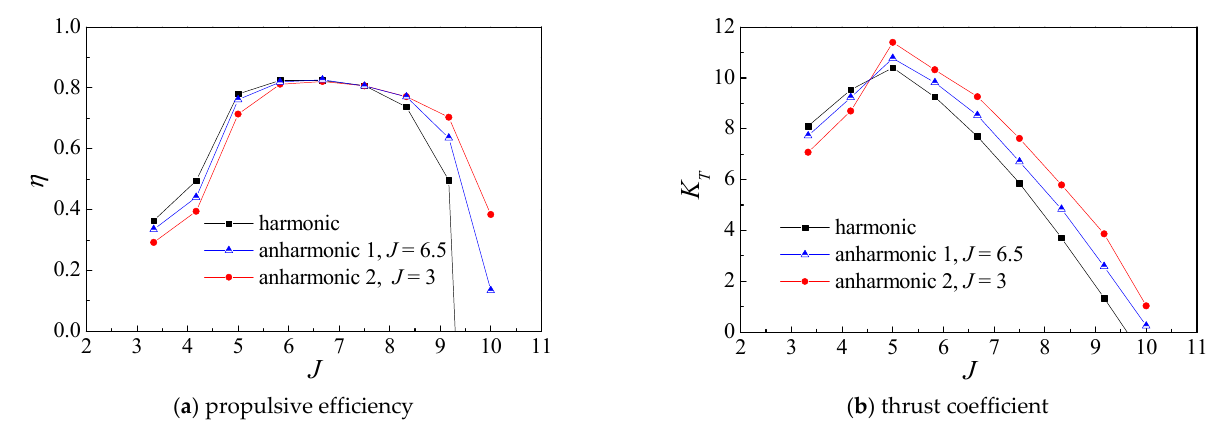
Figure 20. Comparison of efficiency and thrust coefficient in the case of simple harmonic and two kinds of anharmonic pitching angle trajectory when the heaving motion is simple harmonic.